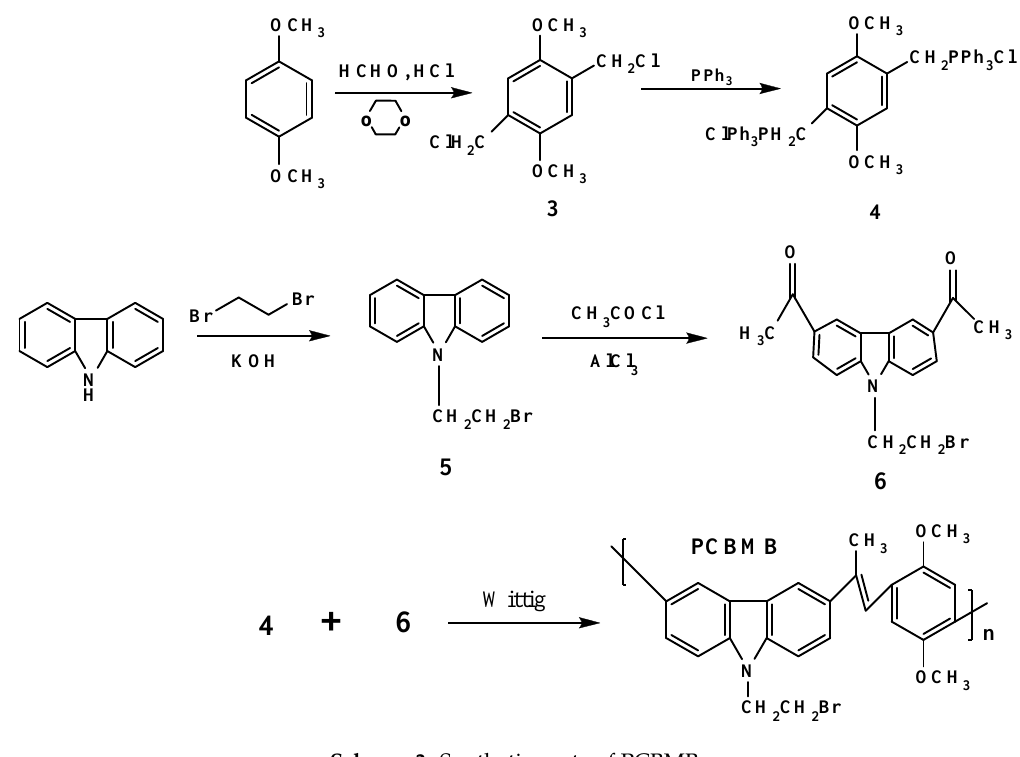
Scheme 3. Synthetic route of PCBMB.